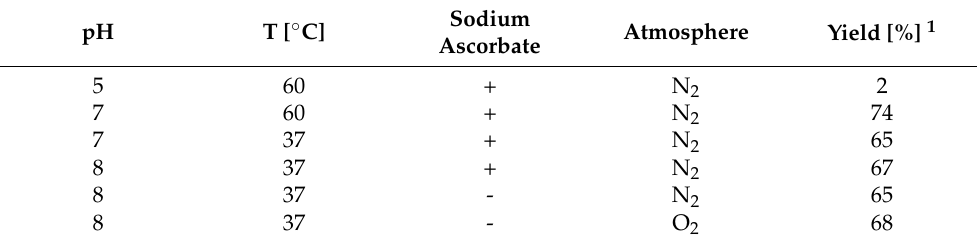
Table 2. Parameters influencing the Pictet-Spengler reaction.